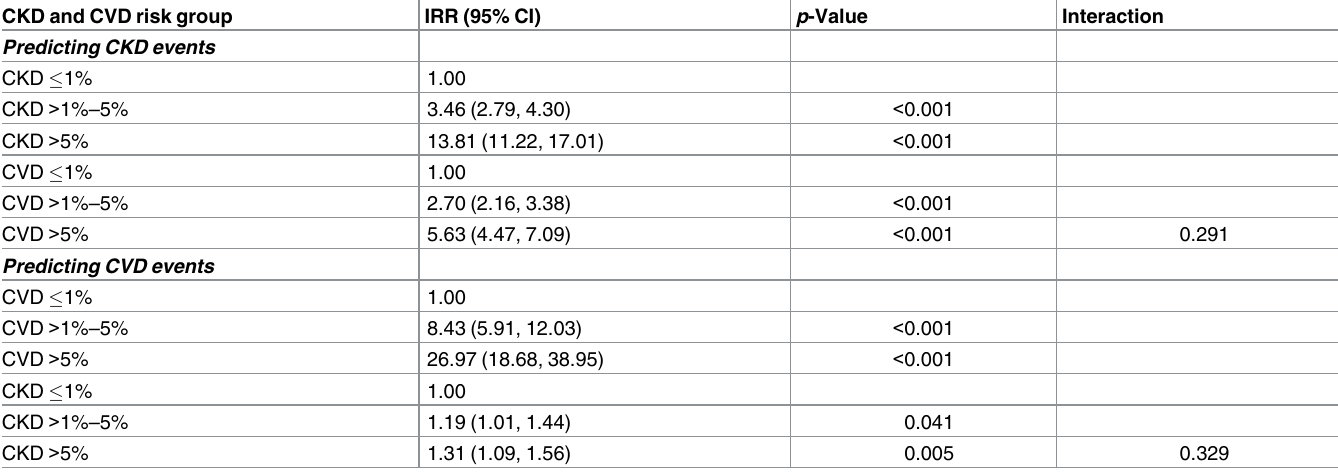
Table 3. Combined effect of CKD and CVD risk groups in predicting CKD and CVD events. CKD and CVD risk